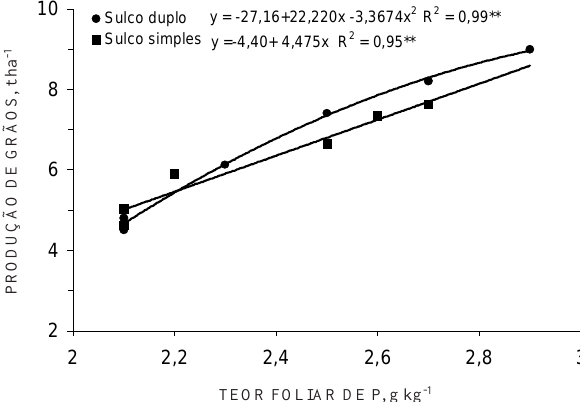
Figura 3. Relação do teor foliar de P e a produção de grãos de milho, considerando os modos de aplicação em sulco duplo e sulco